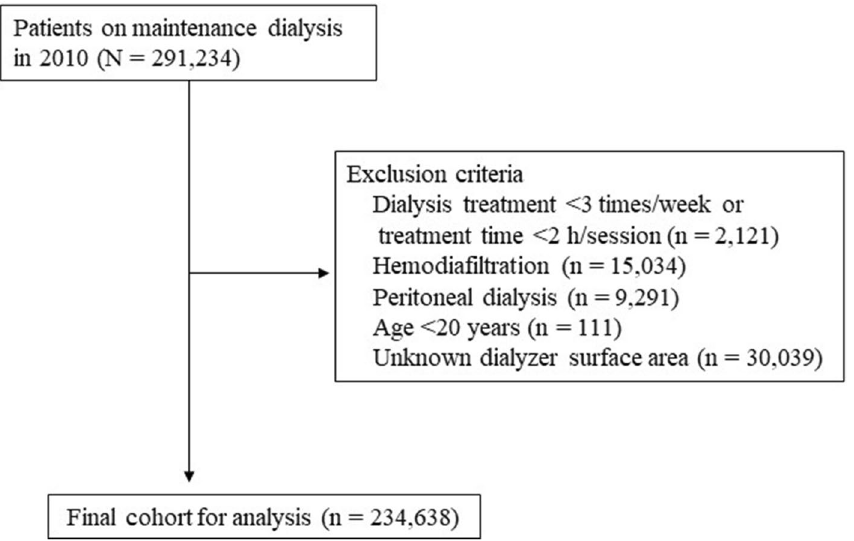
Figure 1. Flowchart showing the process used to extract the data analyzed in this